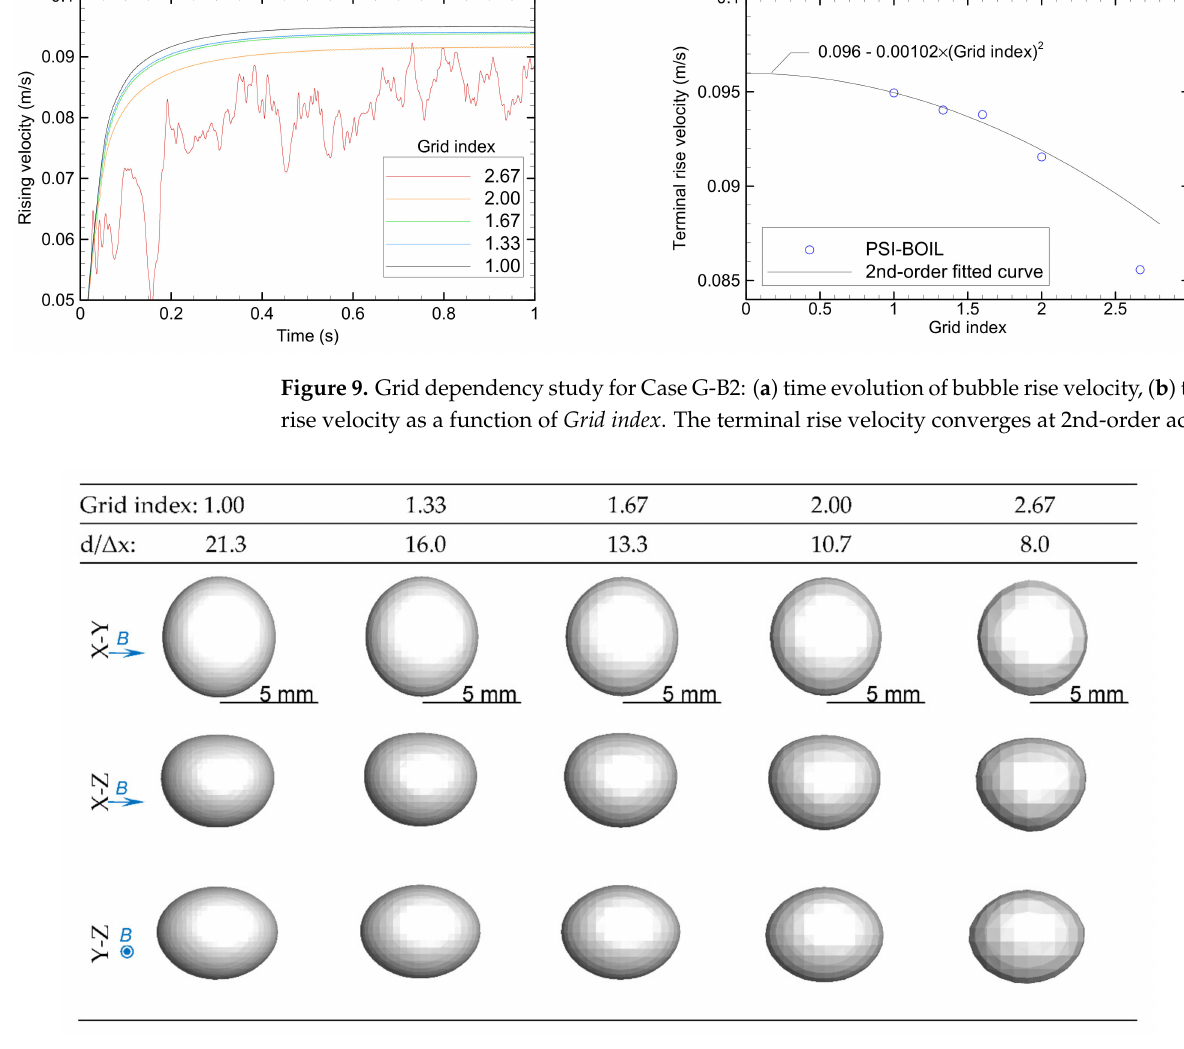
Figure 10. Grid dependence of the bubble shape in the three coordinate planes at t = 1 s for case G-B2.